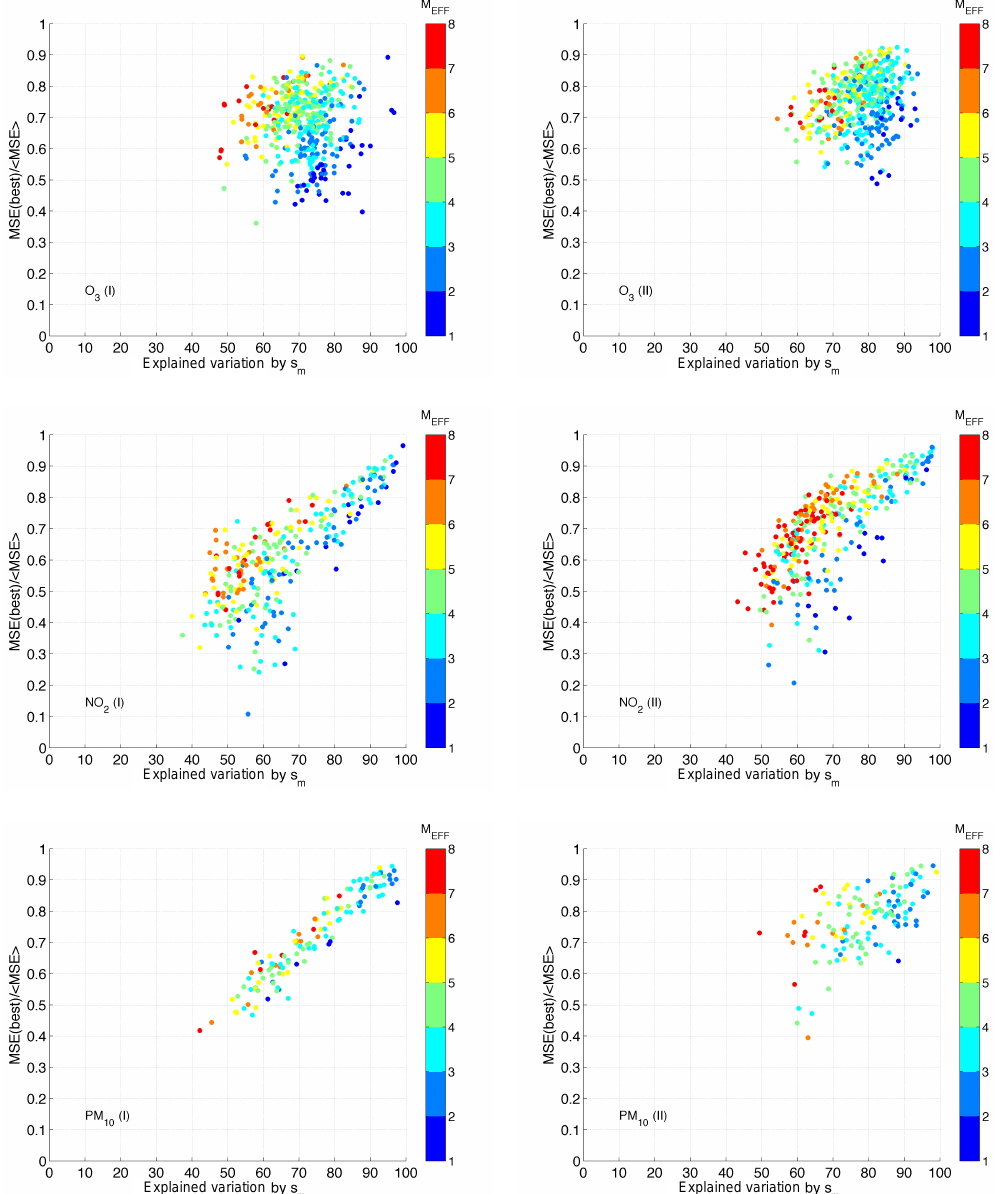
Figure 6. Like Fig. 5 but showing the N EFF with respect to skill difference and error dependence.